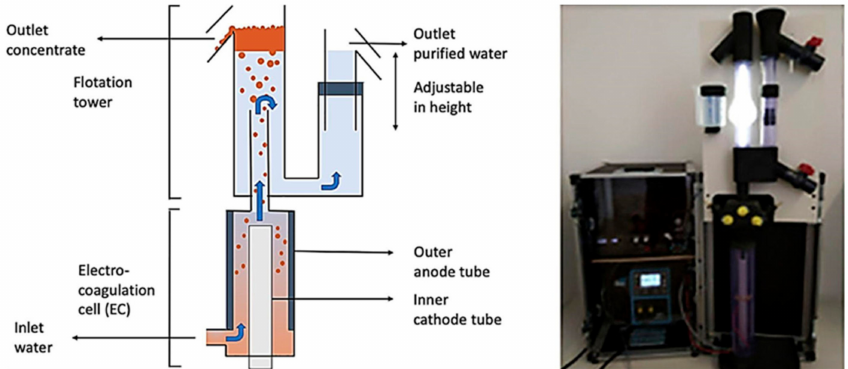
Figure 20. Schematic diagram and setup of the electrocoagulation-flotation tubular reactor (adapted from Parmentier et al.